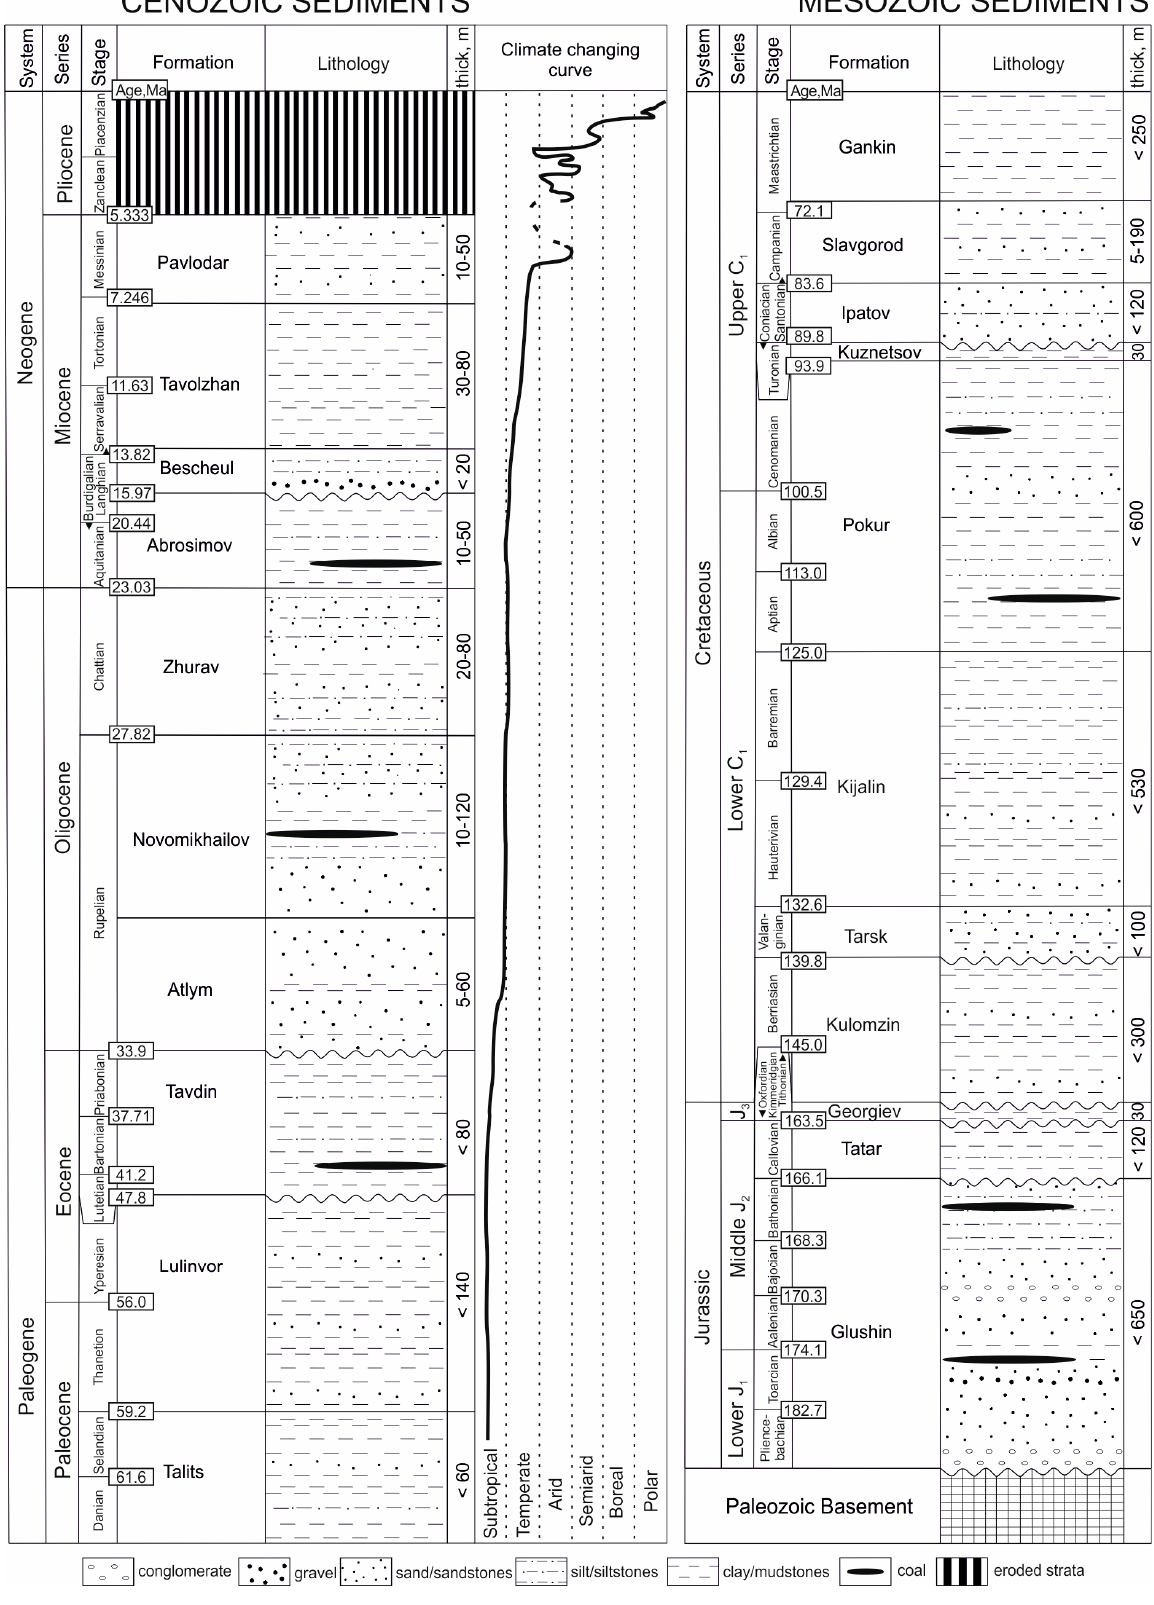
Figure 2. Schematic stratigraphic column of the Mesozoic and Cenozoic sediments of the Southeastern West Siberian Basin with indication of climatic conditions (climate oscillation curve after [27]). Absolute ages of stage boundaries shown are according to [28].